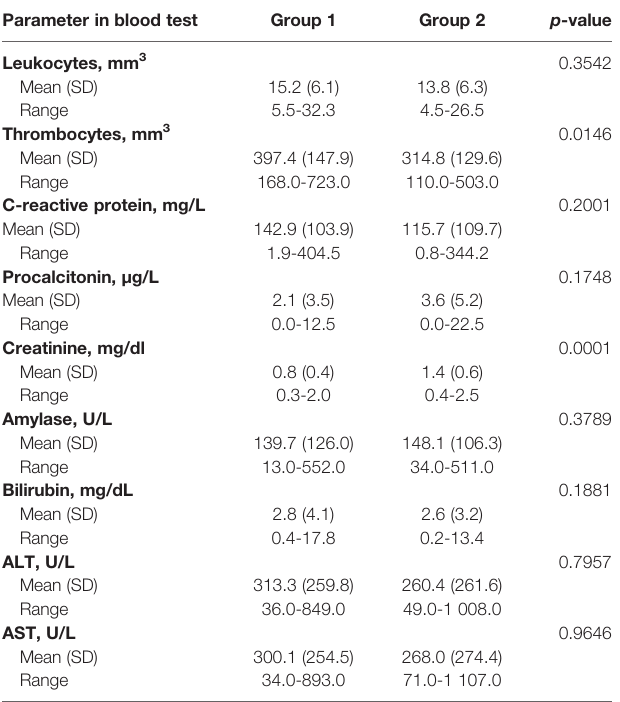
TABLE 2 | Parameters in laboratory blood test in patients with PPPFCs before the endotherapy. Parameter in blood test Group 1 Group